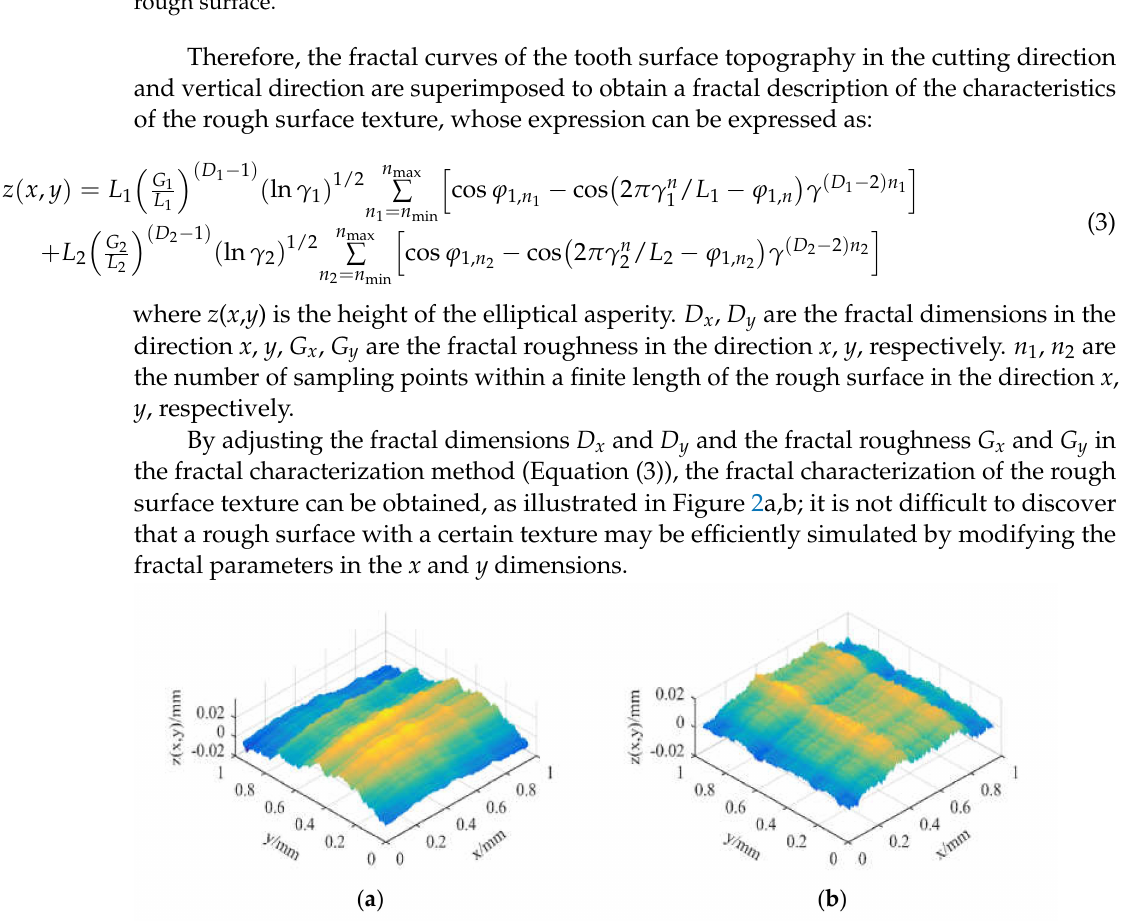
Figure 1. Roughness measurements of a beveloid gear tooth surface. ( a ) The measurement experi- ment of tooth surface topography; ( b ) The three-dimensional morphological characteristics of the rough surface.